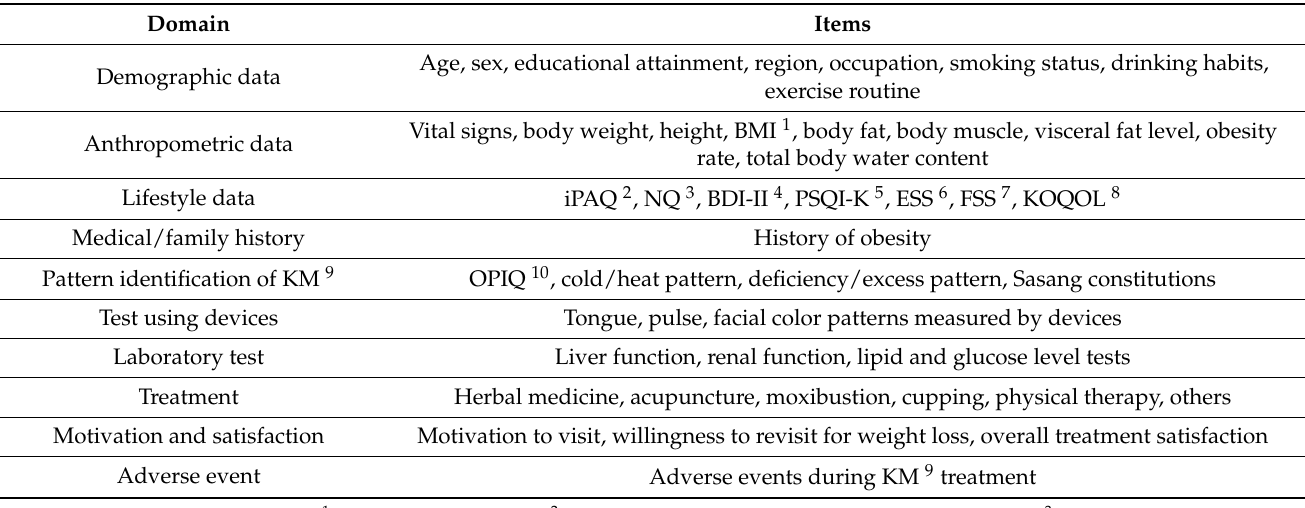
Table 1. Detailed data